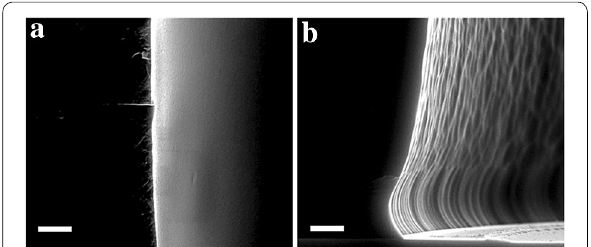
Fig. 6 Cross‑sectional SEM images of DRIE trench smoothened using the optimized RIE condition of 100 W RF power and 30 sccm SF 6 flow for 30 min. Cross‑sectional SEM images of the sidewall ( a ) near the top and ( b ) at the bottom of the trench. All scale bars in SEM images are 1